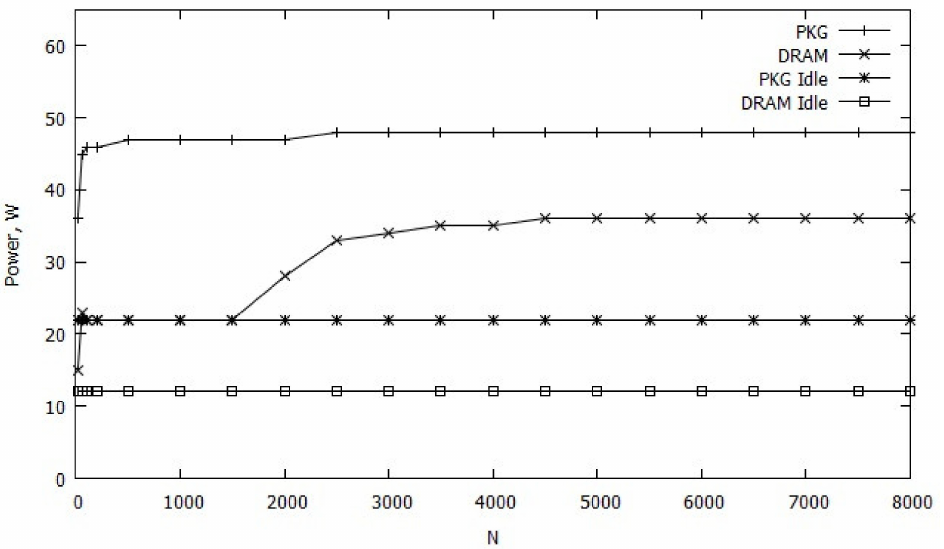
Figure 7. The dependence of the power consumed in the software execution process on the problem dimension (classical scheme).